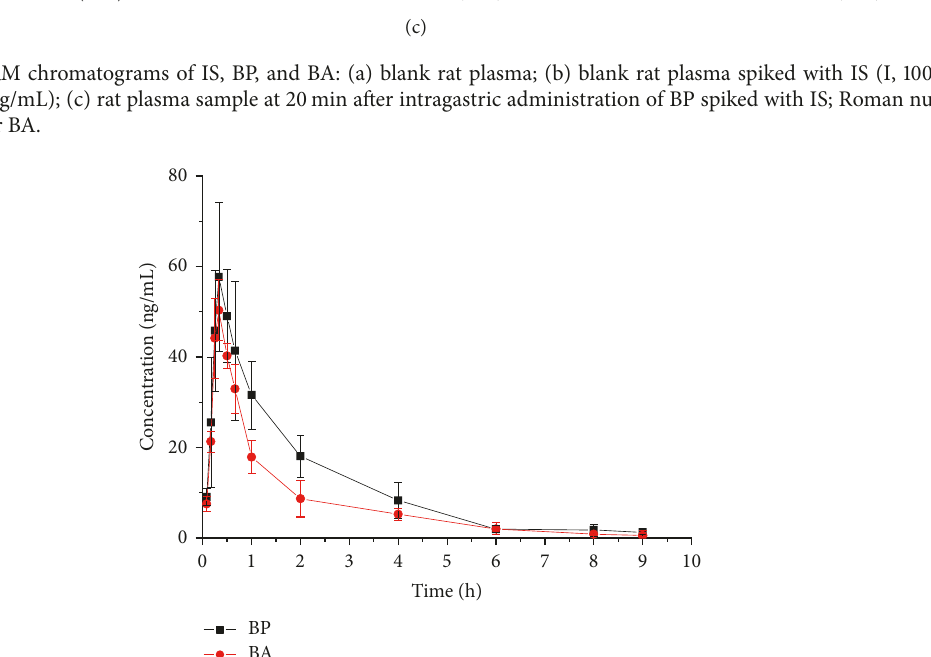
Figure 5: Mean plasma concentration-time profiles of BP and BA in rats after intragastric administration. Data are mean ± SD ( 𝑛 = 6